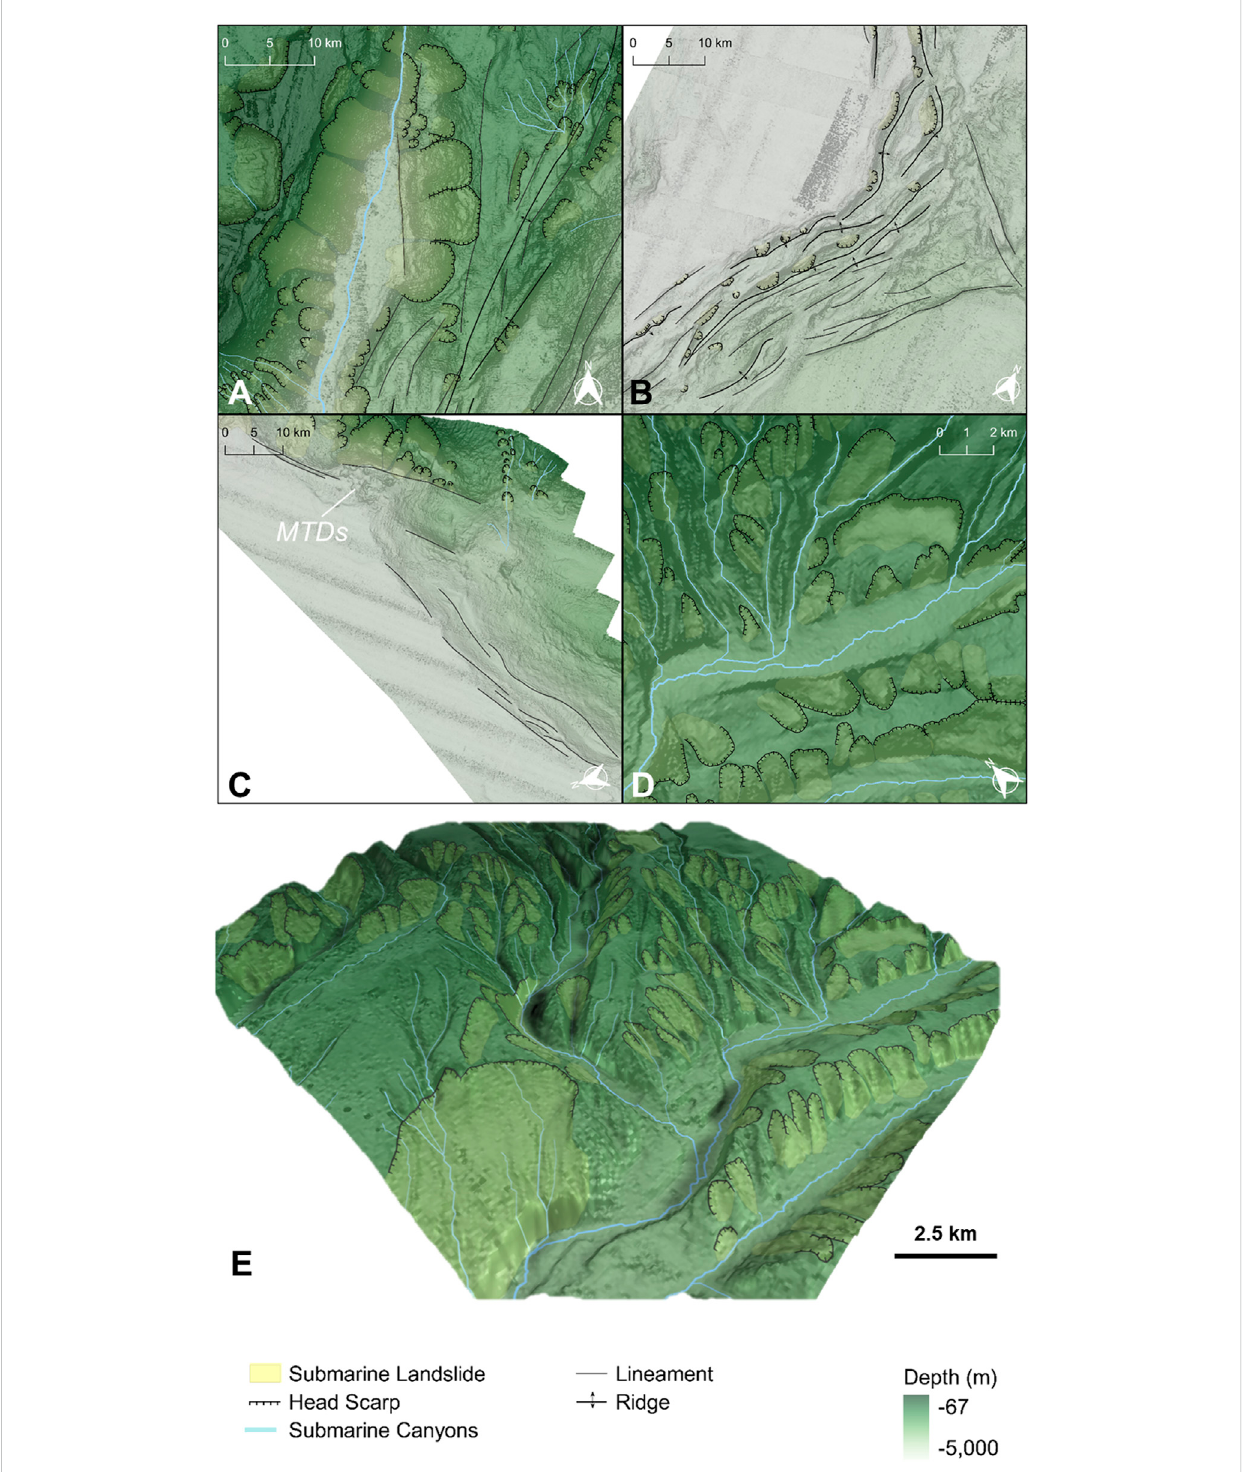
FIGURE 5 Close-up view of the mapped submarine features (see Figure 4 for their location). (A) Large submarine landslides along the steep frontal wedge of the northern NT segment (NT1) and steep bathymetry of the colliding Cagayan Ridge (CR) in the west. Between the frontal wedge and the CR is a deeply incised submarine canyon that is parallel to the trench. (B) Prominent deformation front and associated submarine features of the frontal wedge in the northernSTsegment(ST1). (C) Poorlydevelopedfrontalwedge,submarinecanyons,andsubmarinelandslidesinthesouthernSTsegment(ST2). (D) Well-developed networks of submarine canyons and associated submarine landslides offshore of southern Negros island. (E) Three-dimensional perspective of submarine landslides in Figure